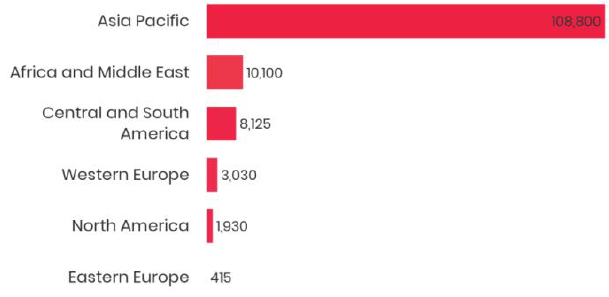
Fig. 1. Projected motorcycles sales worldwide (in thousand units) in 2018 by region